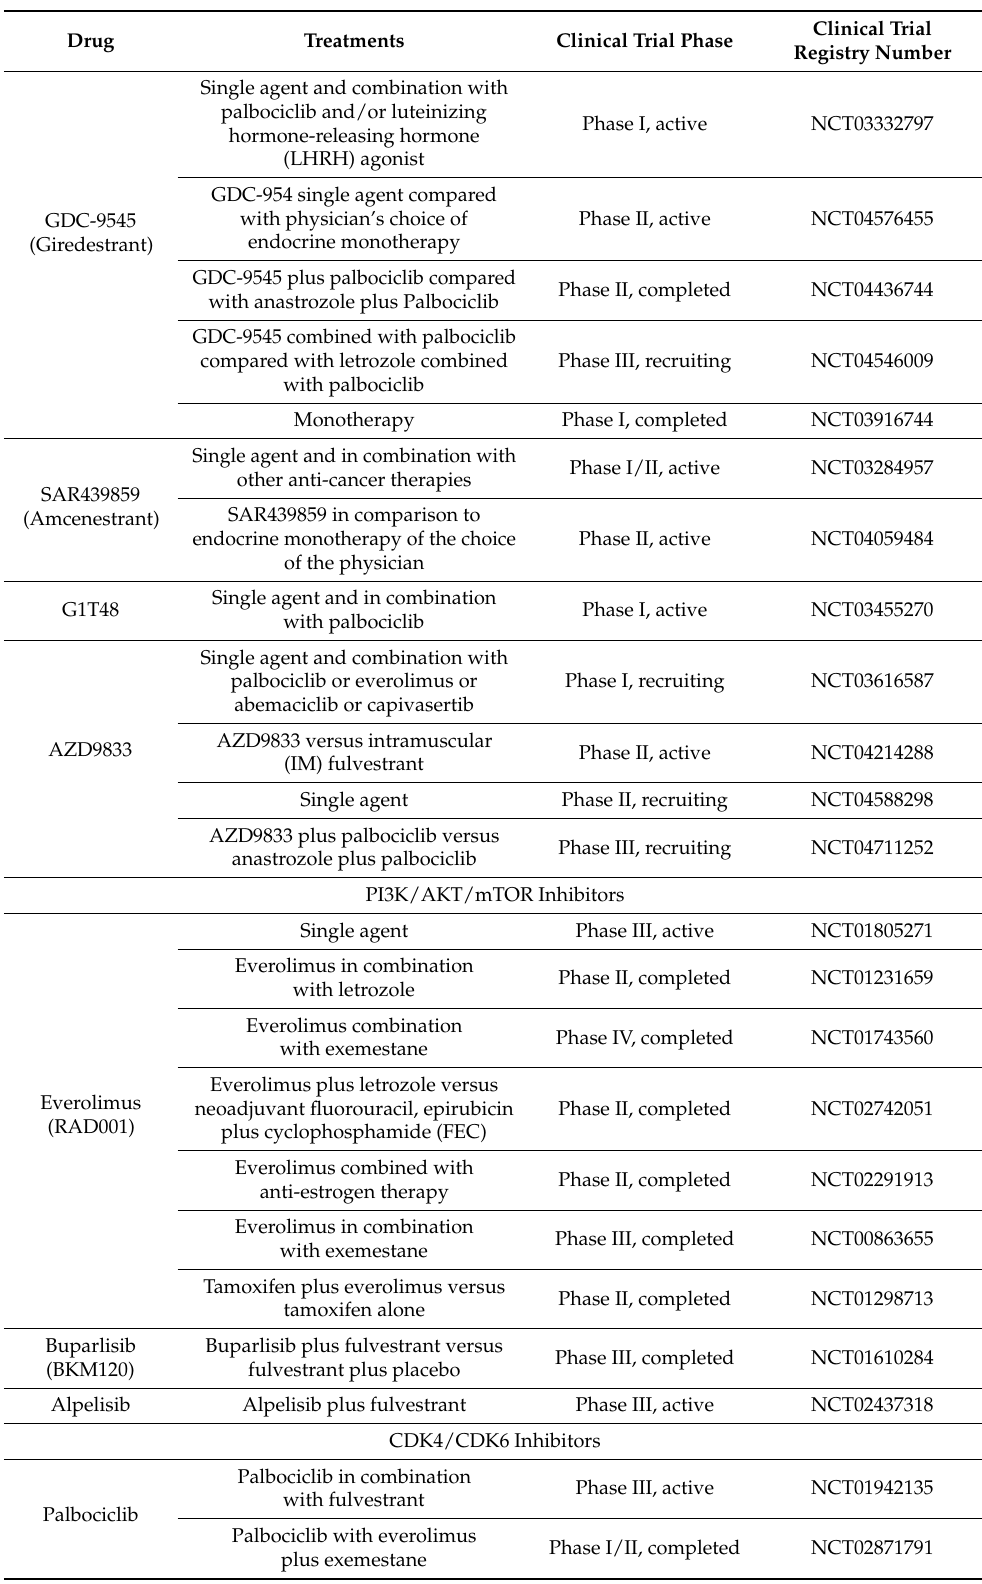
Clinical Trial Registry Number